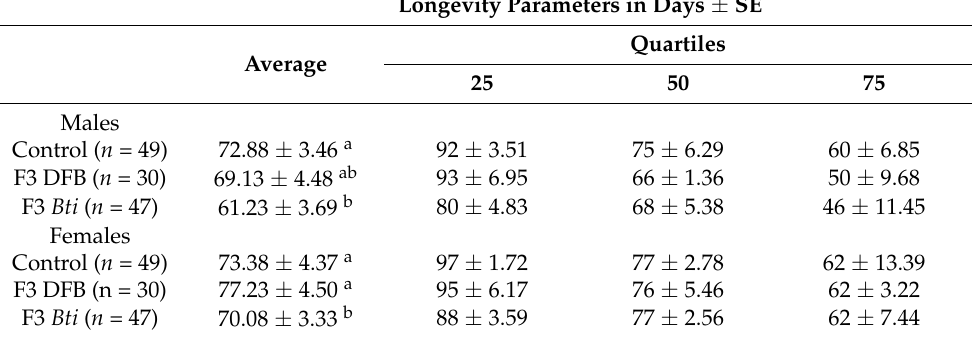
Table 4. Longevity parameters of Culex pipiens f. molestus populations that were either selected against diflubenzuron (DFB) and Bti for three successive generations or not (control). Adults were maintained at the same place (warehouse) where they developed as larvae during winter, having access to 5% sugar solution. Within sex, different letters indicate significant differences (pairwise comparisons log-rank test, p < 0.05).